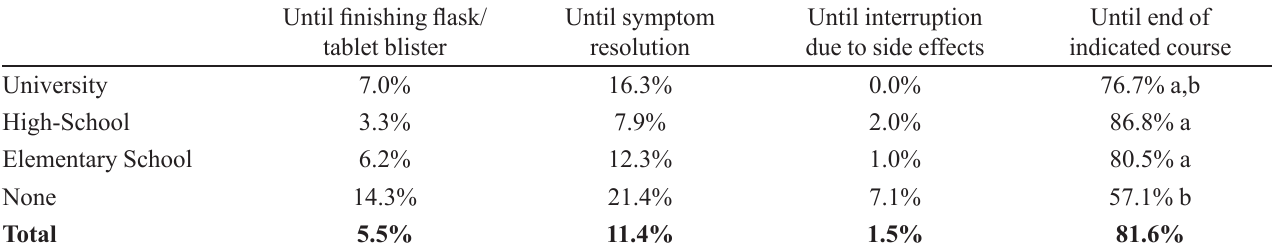
TABLE III – Percentage distribution of time in use of antibiotic by educational